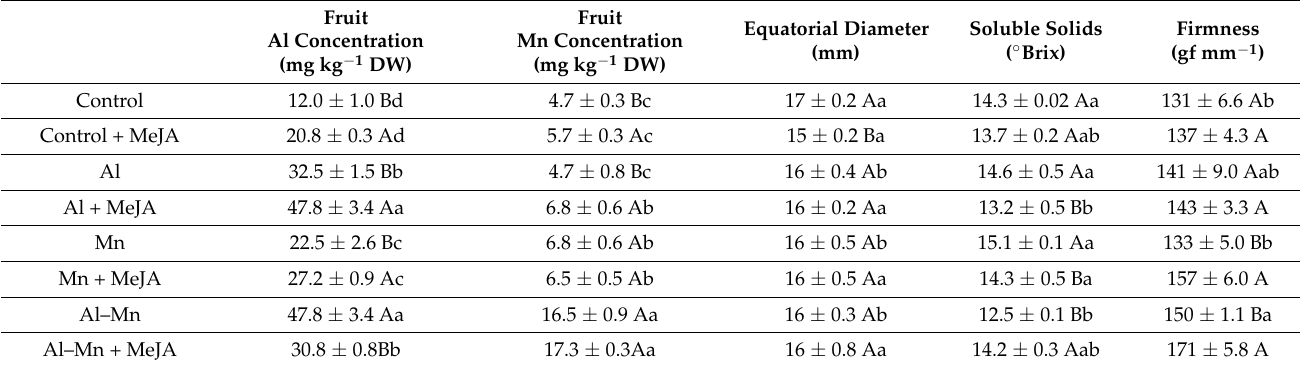
Table 2. Aluminum and manganese concentrations and quality of fruits in highbush blueberry cv. Legacy plants subjected to different soil treatments (Al, Mn, and Al–Mn toxicity), and exogenous MeJA. All values represent averages of 10 biological replicates ± SE. Different upper-case letters indicate significant differences between MeJA treatments for the same soil conditions according to Tukey’s test ( p ≤ 0.01). Different lower-case letters indicate significant differences among soil conditions for the same MeJA treatment according to Tukey’s test ( p ≤